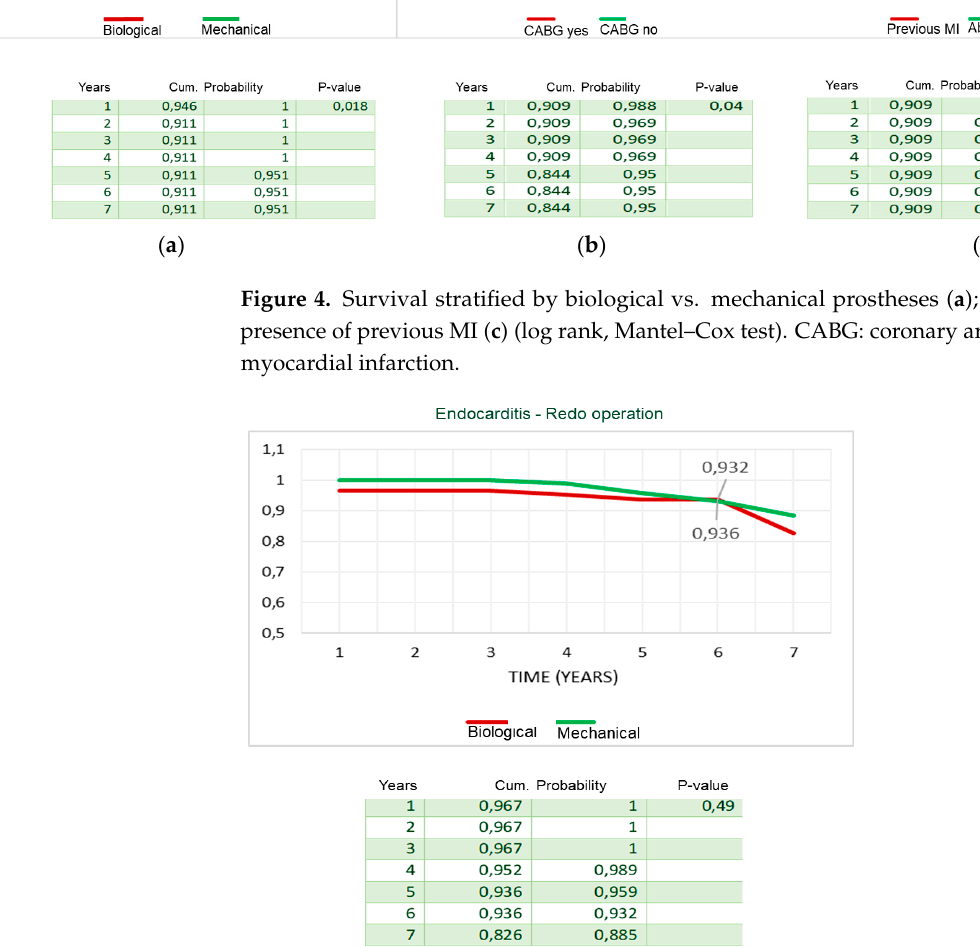
Figure 6. Adverse-event-free survival stratified by concomitant CABG (Mantel–Cox test). CABG: coronary artery bypass grafting.